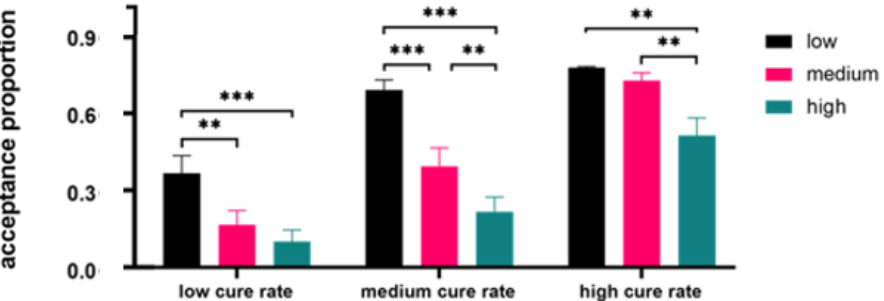
Figure 4. Mean of ‘yes’ responses for the nine conditions and their standard errors (SE). **: p < 0.01; ***: p < 0.001.